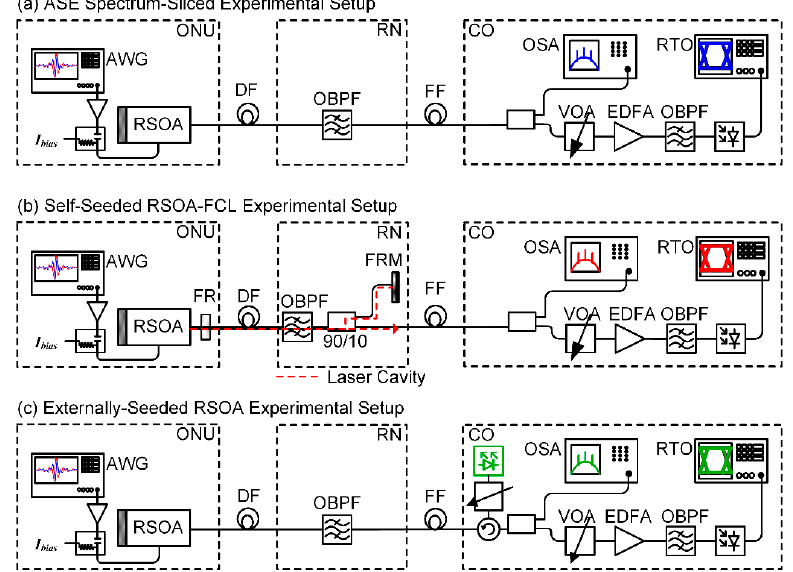
Figure 4. Experimental setups of three RSOA based colorless transmitter schemes in a WDM-PON scenario: ( a ) ASE spectrum-sliced, ( b ) self-seeded RSOA-FCL, and ( c ) externally seeded RSOA. At the optical network units (ONUs), the upstream signal from the arbitrary waveform generator (AWG) is amplified and added to a bias current to drive the RSOA. The ONU and the remote node (RN) are connected by the distribution fiber (DF). At the RN, an optical bandpass filter (OBPF) mimics the WDM filter. In the case of the RSOA-FCL in ( b ), the Faraday rotator mirror (FRM) is placed behind the filter and a coupler to form the Fabrey-Perot cavity, shown by the red dashed line. For the externally-seeded RSOA in ( c ), the seeding cw laser is place at the central office (CO). On the receiver side at the CO, pre-amplification and direct detection are performed. A real-time oscilloscope (RTO) records